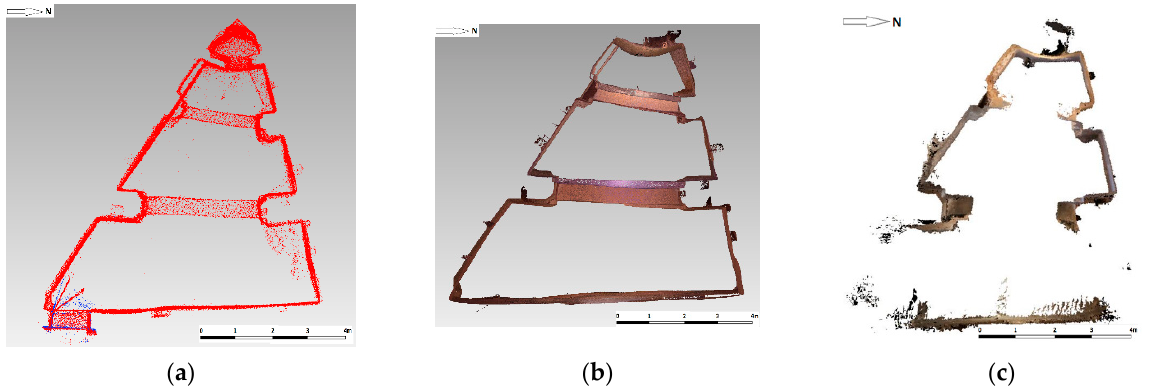
Figure 14. Ground schemes from ZEB-REVO ( a ), BLK360 ( b ), and iPhone ( c ); you can see that with the handheld scanner, the spaces behind the wall (behind the tip of the triangle) can also be documented. The model from photos, taken by an iPhone 7, was not very good due to bad lighting, inappropriate texture, combined with a short time for taking photos; however it is not a typical result from close-range photogrammetry, that can create high-quality 3D models.